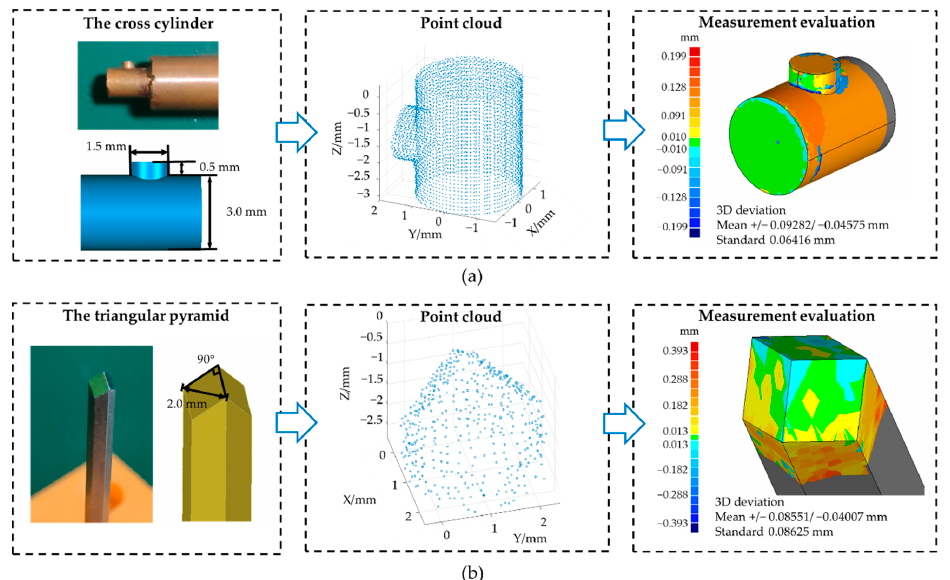
Figure 12. Application results on two tiny parts: ( a ) a cross cylinder; ( b ) a microtriangular pyramid.